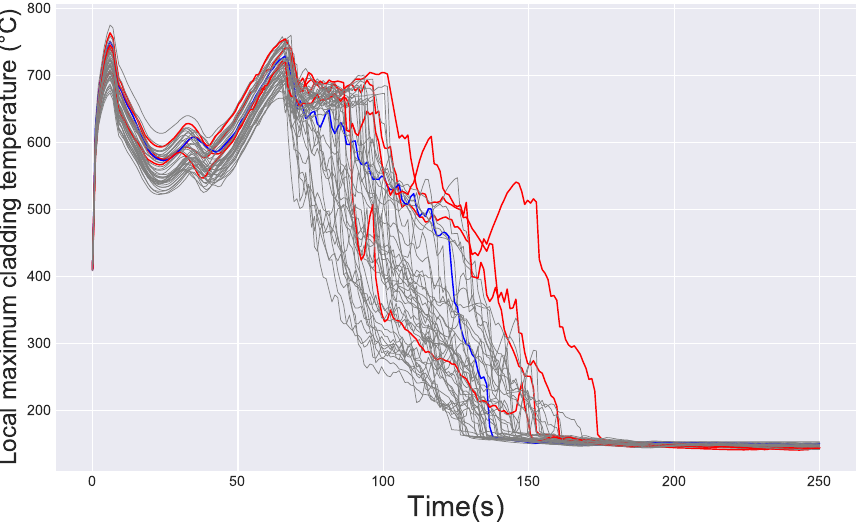
Figure 3. IBLOCA transient curves presenting the highest degree of outlyingness (red) and the least outlying curve